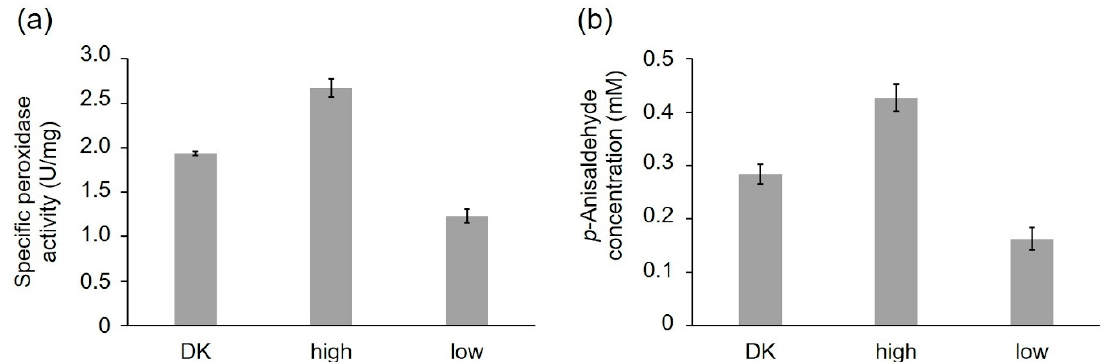
Figure 6. Comparison of the PsaPOX variants regarding their peroxidase and alkene cleavage activity. ( a ) Specific peroxidase activity. Values are the average of triplicate measurements using three independent replicates with standard deviations shown as error bars ( b ) p -Anisaldehyde concentration after bioconversion of trans -anethole (6.7 mM) using 0.25 mg/mL PsaPOX variant in the presence of 25 mM MnSO 4 , 100 µM H 2 O 2 , and 50 mM sodium acetate buffer pH 3.5 for 16 h at RT and 200 rpm. Values are the average of duplicate independent experiments with standard deviations shown as error bars. DK: PsaPOX_DK; high: PsaPOX_high; low: PsaPOX_low.